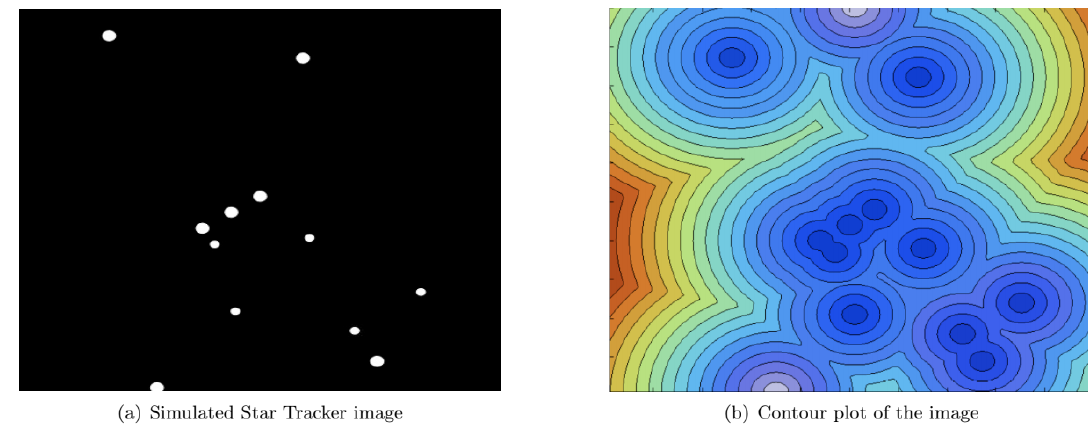
Figure 6. Shortest distance transform feature extraction (reprinted from